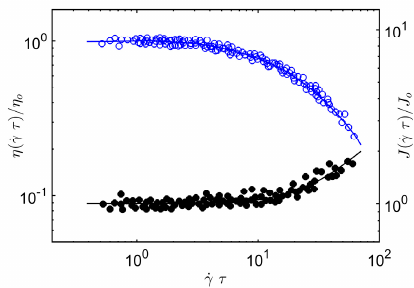
. . Figure 2. Shear viscosity η ( γτ ) and compliance J ( γτ ) of “entangled” poly(alpha-methylstyrene) melt Figure 2. Shear viscosity η (  (cid:4662) τ ) and compliance J (  (cid:4662) τ ) of “entangled” poly(alpha-methylstyrene) melt . γτ . Solid lines denote Equations (10) under steady-shear conditions as a function of reduced shear rate, under steady-shear conditions as a function of reduced shear rate,  (cid:4662) τ . Solid lines denote Equations and (12) of the present paper and the data is taken from Sakai et al. (10) and (12) of the present paper and the data is taken from Sakai et al. [55].